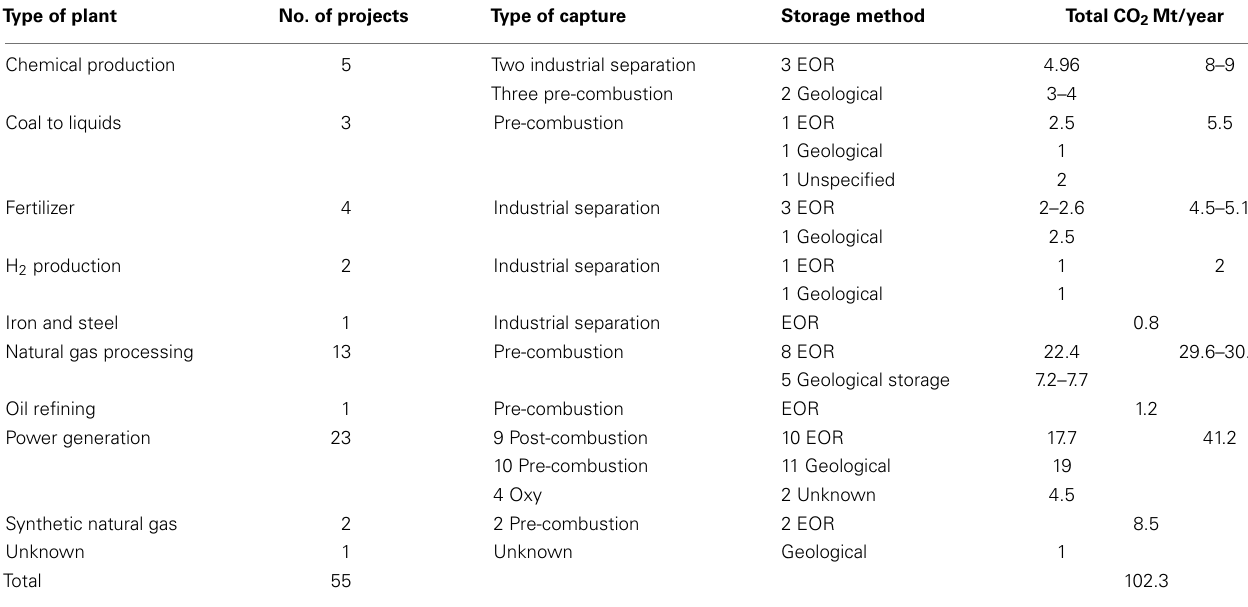
Table 1 |The global status of CSS projects in 2014 [adapted from Global CCS Institute database (2014)] . Type of